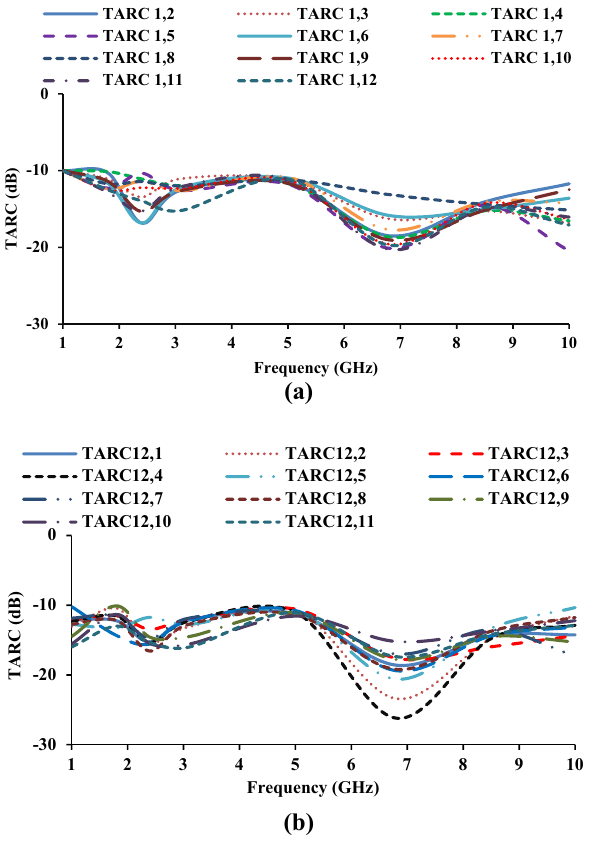
Figure 15. TARC of the MIMO antenna: ( a ) with respect to port-1, ( b ) with respect to